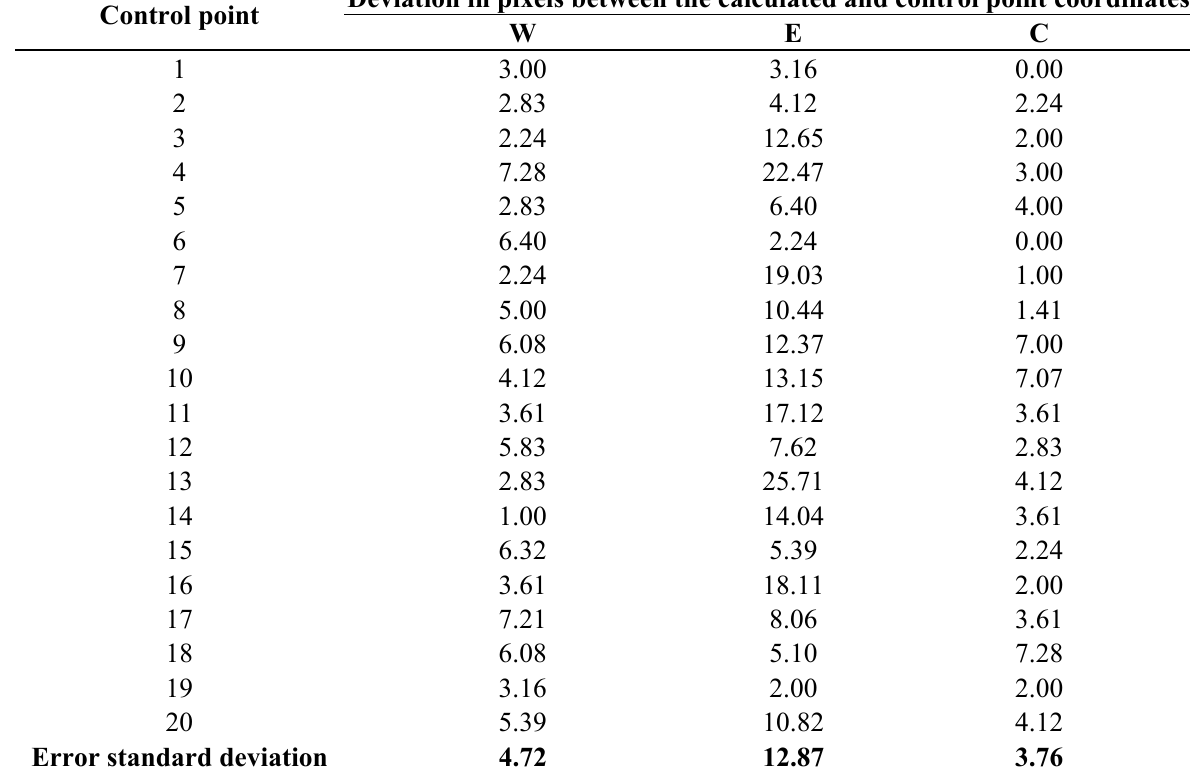
Table 2. Deviation (in pixels) between the calculated and control point coordinates.